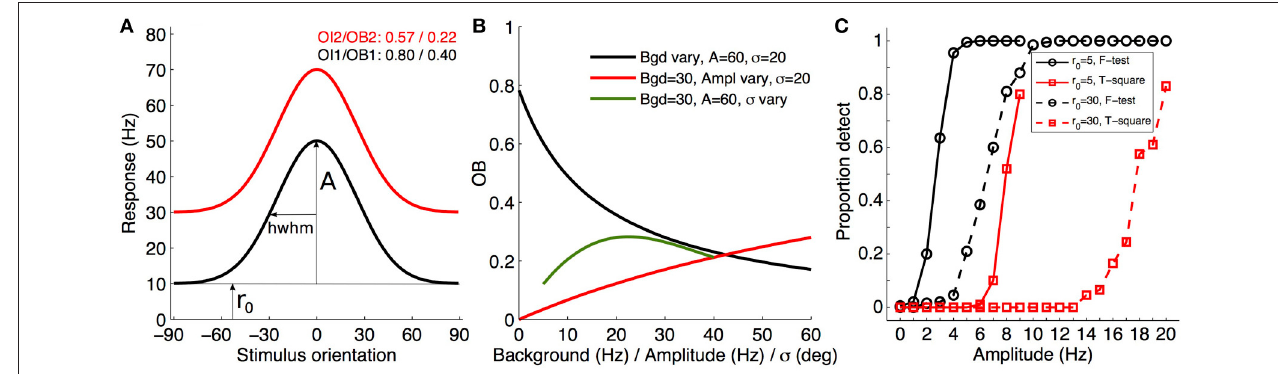
FIGURE 1 | Illustration of tuning, index variations, and statistical decision about tuning presence. (A) Examples of two theoretical orientation-tuned cells only differing in background firing rate (r 0 of 10 and 30 Hz; Gaussian curves with amplitudes of 40 Hz and σ of 25 ◦ ) and their associated OI/OB (A, amplitude; hwhm, half-width at half-maximum). (B) Illustration of the variation of the orientation bias index (Leventhal et al., 1995) for Gaussian orientation-tuned cells when only one of the three parameters varies, with the two other fixed (see legend), demonstrating the difficulty of interpreting OI/OB variables without knowledge of the tuning parameters. (C) Proportion of detected tuned cells of a given amplitude (abscissa) when applying the Hotelling T 2 -test (red curves) or F -test (black curves), and for two different background firing rates (5 Hz in solid lines, 30 Hz in dashed lines). The model response was a von Mises direction-tuned cell (parameters: r 0 , a 1 = 50 Hz, a 2 = 0 Hz, k = 0.95, giving hwhm ∼ 32.6 ◦ ; see Swindale, 1998), experimental sampling was every 15 ◦ (e.g., Schmolesky et al., 2000) with 10 repetitions per direction, and random noise around the mean was simulated as Poisson type. A total of 200 cells were simulated for each amplitude (each symbol in the plot) with random jitter of the preferred orientation across simulations within a 40 ◦ window. Each simulation was fitted with the von Mises two amplitude function (here unconstrained), and the statistical tests applied at α = 0.05/100 for multiple tests adjustment (Matlab code available on demand, or on http://www.researchgate.net/profile/